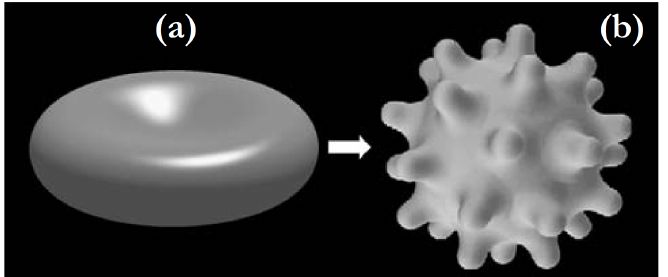
Figure 12. The calculated shapes of erythrocytes determined by minimization of the shear and bending elastic energy (Equations (20) and (21)) for ( a ) ∆ s 0 = 1.038 and ( b ) ∆ s 0 = 6.8. Furthermore, k n / k c = 8 [166], µ / k c = 10 13 m − 2 [161] and the relative cell volume v = 0.6. The cell shapes are determined as described in [28] for shape ( a ) and [44,45,164] for shape ( b ). Adapted with permission from ref. [26]. 2007